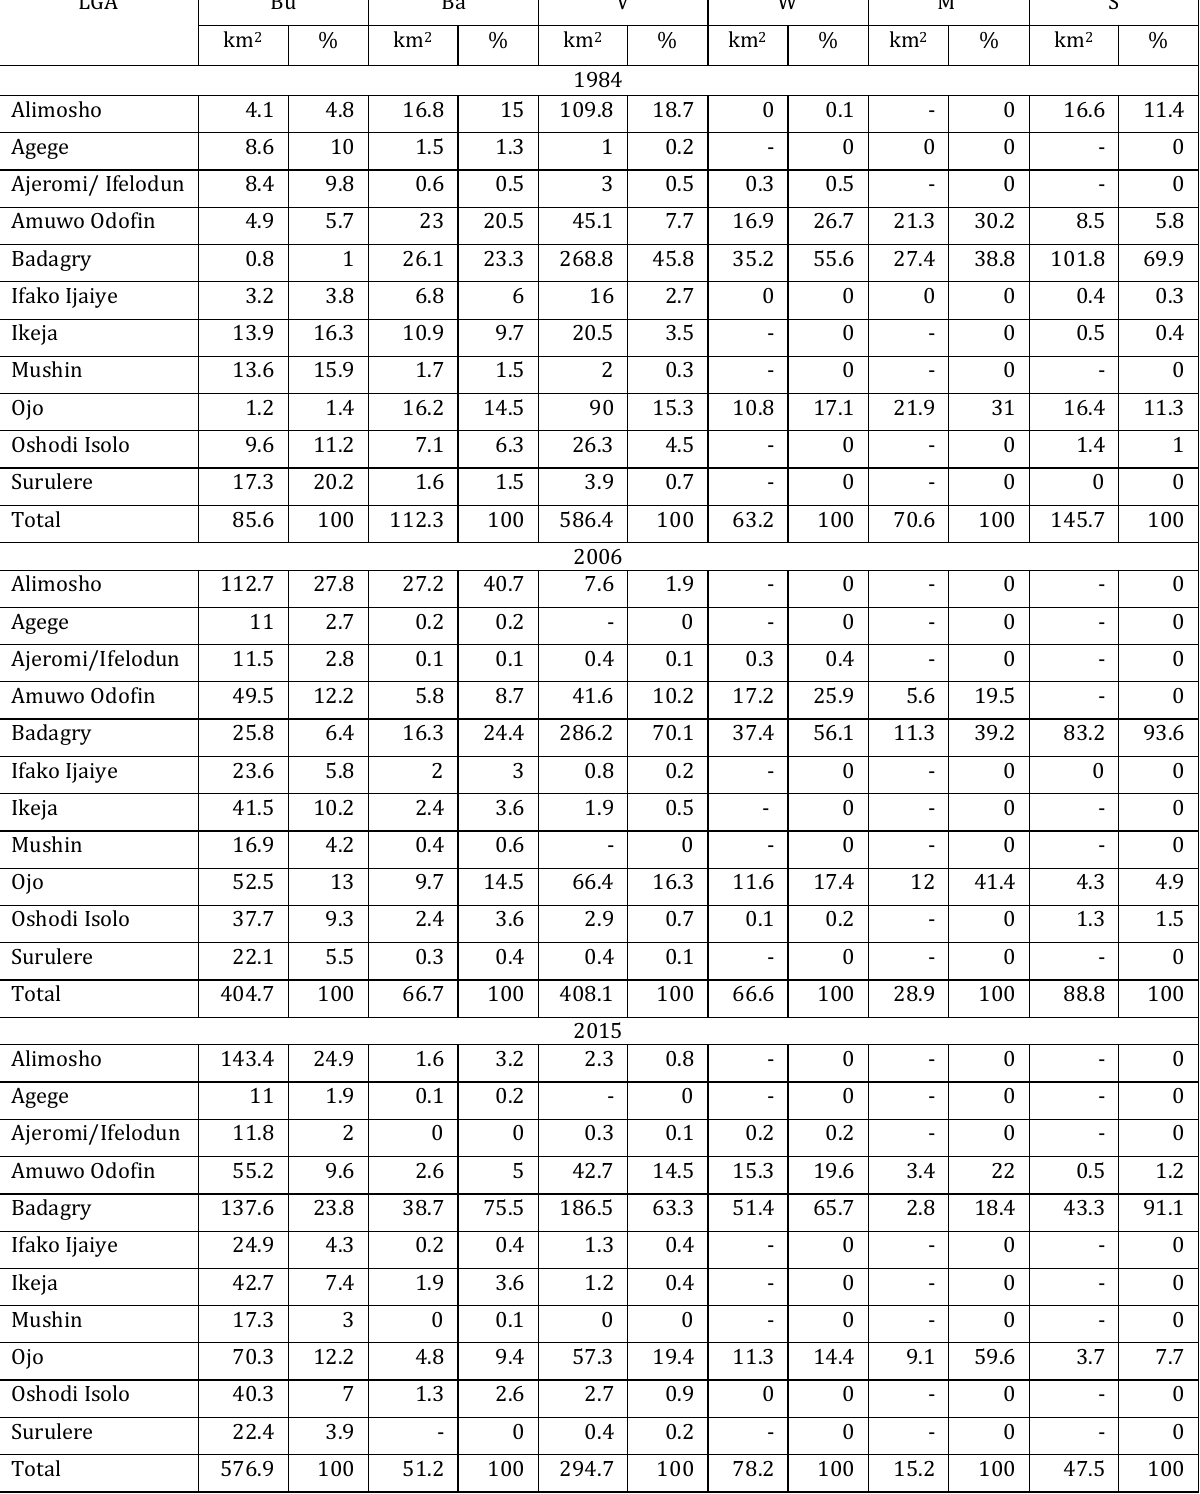
Table 2. Land cover distribution across LGAs – 1984, 2006 and